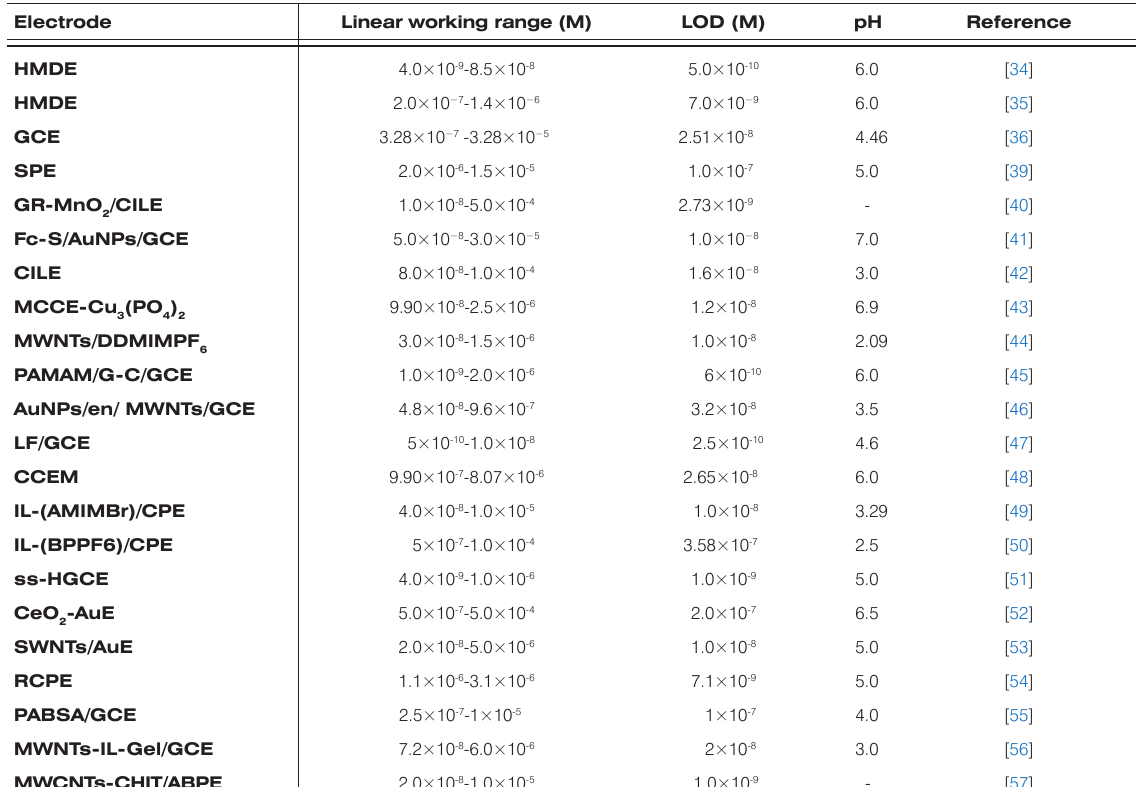
Table 1. Comparison of the analytical performance of some electrodes previously reported for rutin determination.